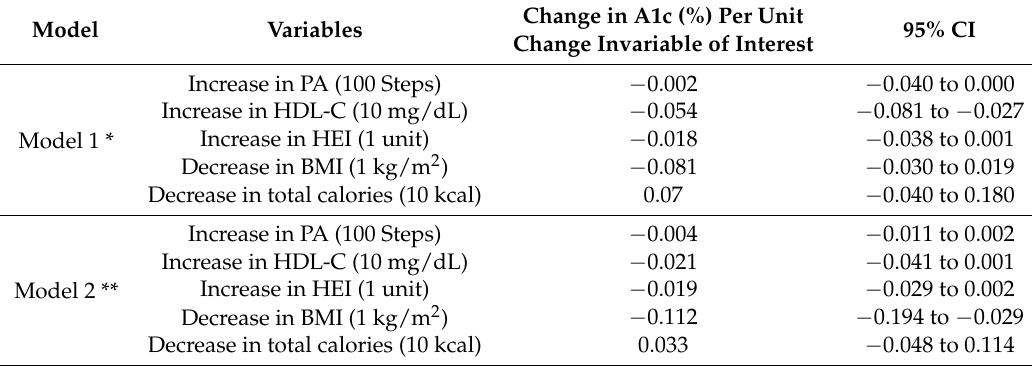
Table 4. Unadjusted and adjusted multiple linear regressions examining variables as predictors of A1c change after the PANDA intervention.